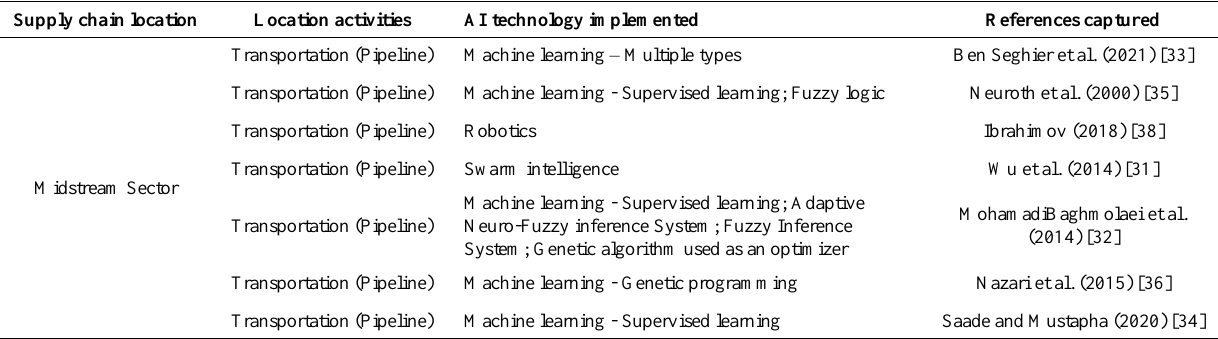
Table 2. Papers focusing on AI technologies applied to midstream activities